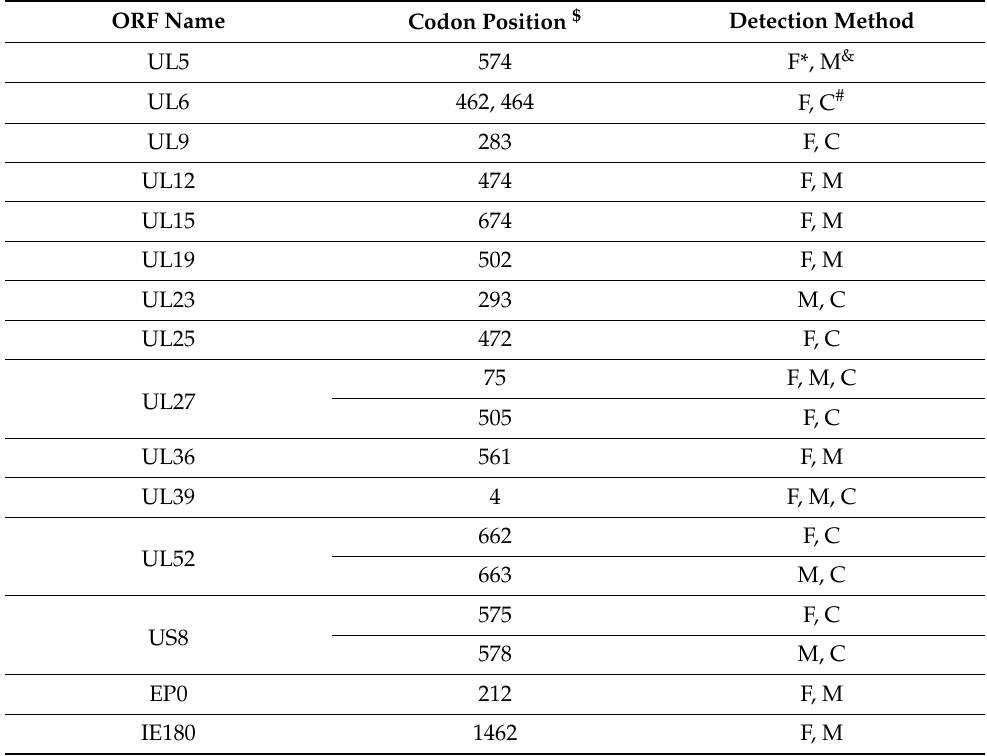
Table 3. Position of each codon under positive